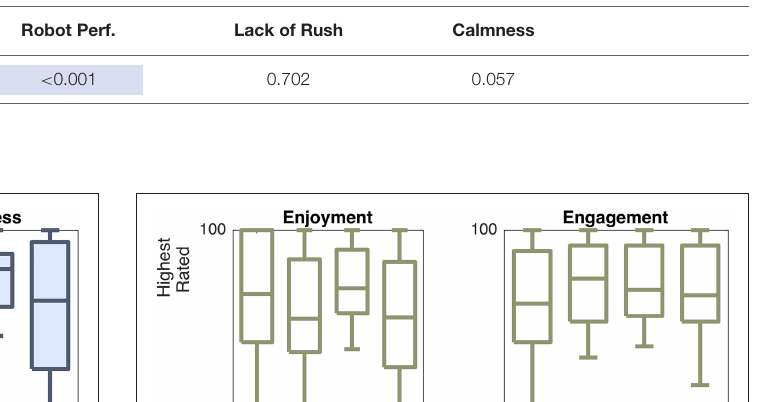
Human Perf. Robot Perf.